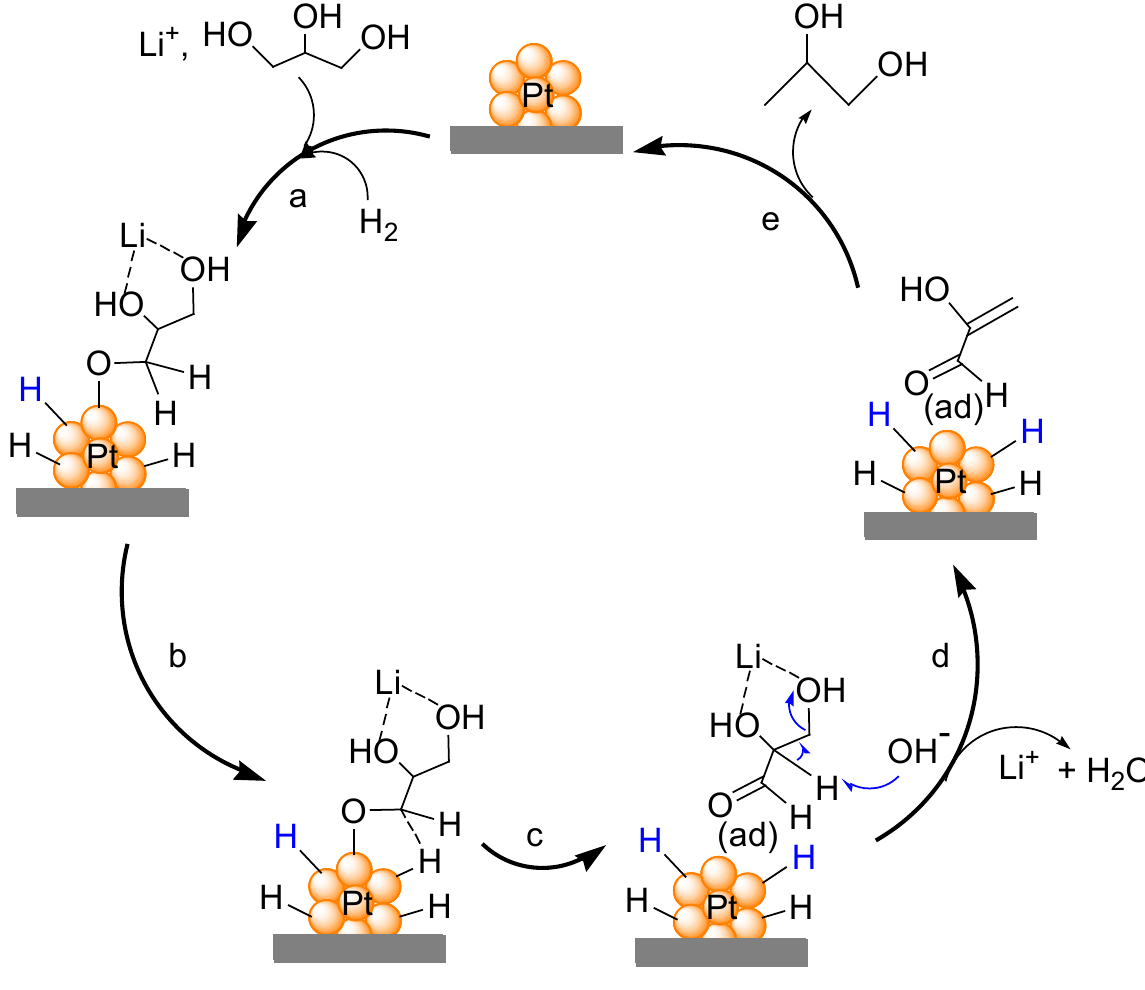
Scheme 2: A possible mechanism for hydrogenolysis of glycerol to 1,2-PDO over Pt/C in the presence of LiOH. Steps a-c: dehydrogenation of glycerol to glyceraldehyde; step d: dehydration of glyceraldehyde to 2-hydroxyacrolein; step e: hydrogenation of 2-hydroxyacrolein to